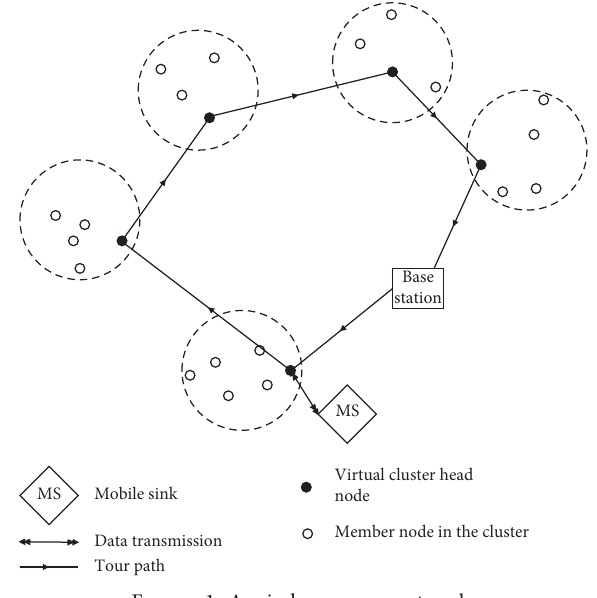
Figure 1: A wireless sensor